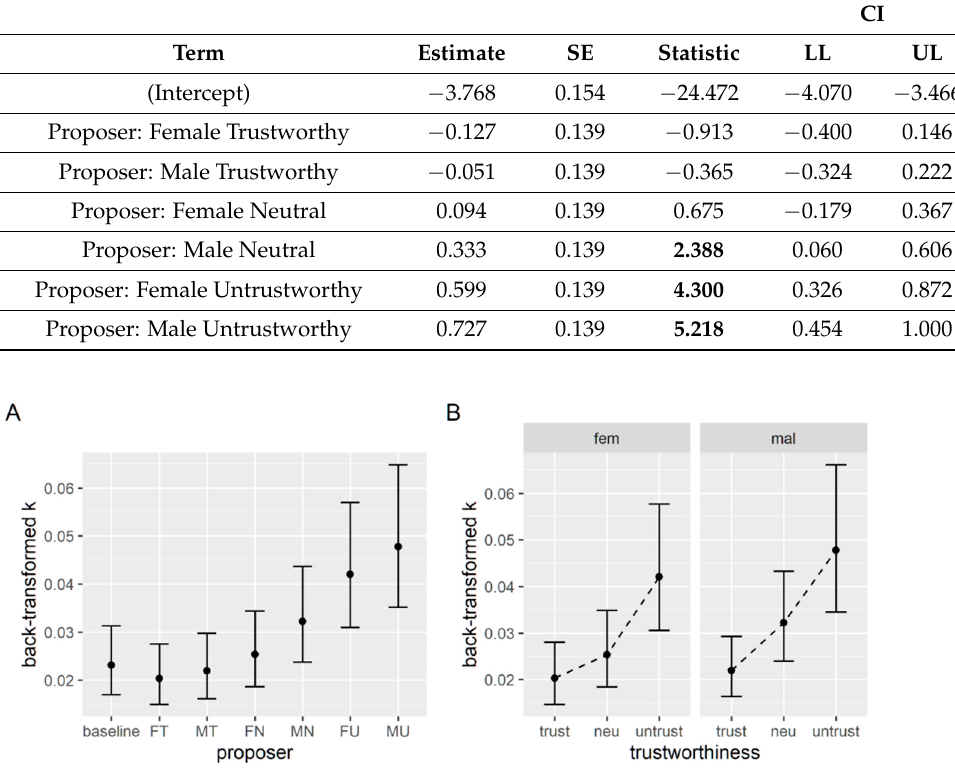
Figure 3. ( A ) Estimated marginal means of k parameters from the first model comparing baseline and each experimental condition. Labels on the x axis indicate the gender (female or male) and trustworthiness (trustworthy, neutral, untrustworthy). ( B ) Estimated marginal means of k parameters for each level of trustworthiness, with female (left) and male (right)